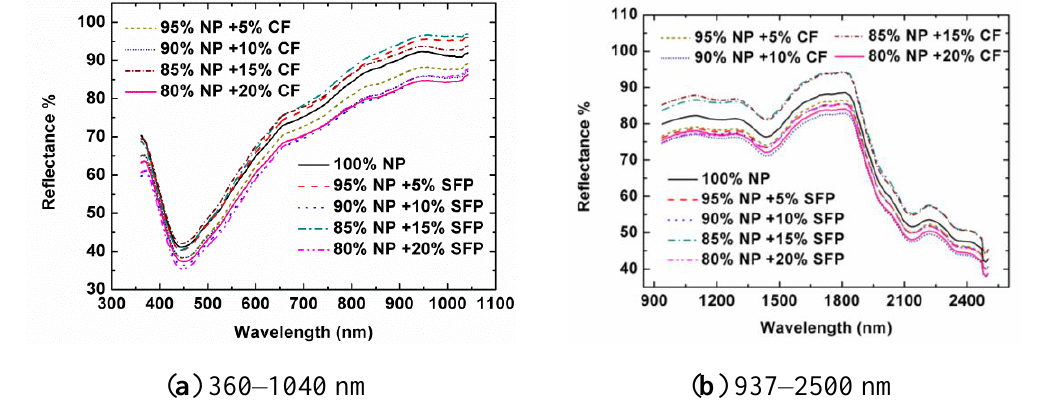
Figure 1. Spectral patterns of the tested notoginseng powder (NP) adulterated by different concentrations of sophora flavescens powder (SFP) and/or corn flour (CF) in 360–1,040 nm ( a ) and 937–2,500 nm ( b ). Percentages are shown by mass